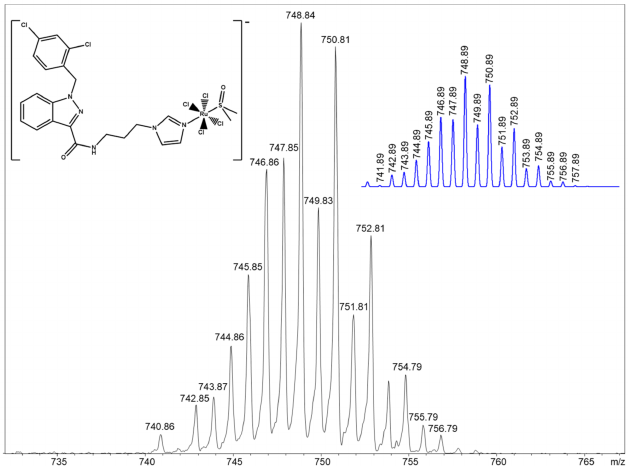
Figure 3. ESI mass spectrum of complex 16